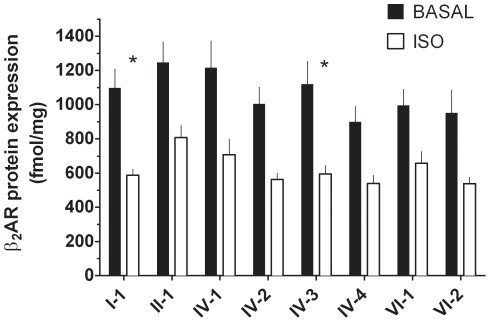
Agonist-promoted downregulation phenotypes of the common ADRB2 haplotypes.Transfected COS-7 cells were exposed to media alone or media with 10 µM isoproterenol for 48 hours. β2AR protein expression was determined by quantitative radioligand binding. The results are from 7 experiments. *, % downregulation from the untreated state differs at p<0.05 vs. all other haplotypes.